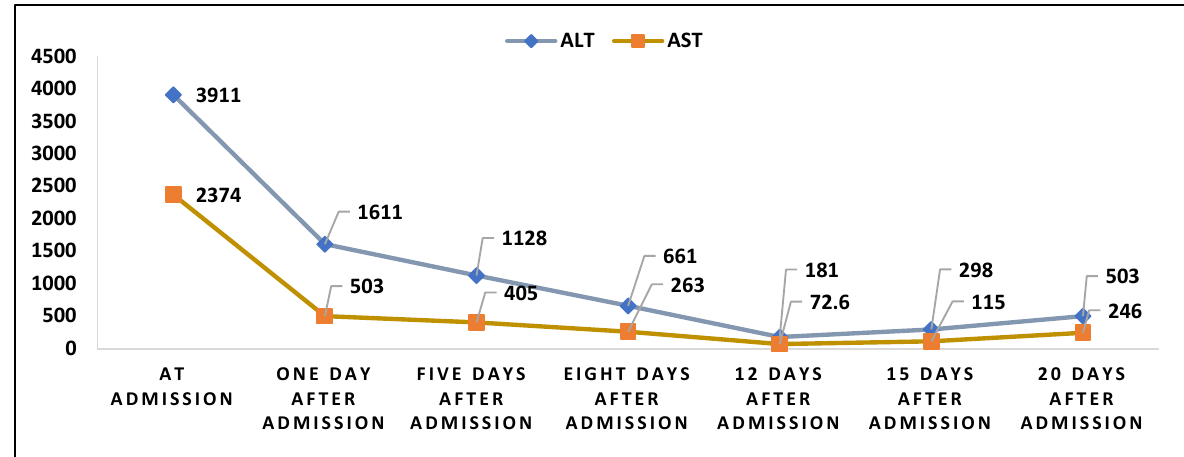
Figure 2. The evolution of ALT and AST levels during hospitalization.